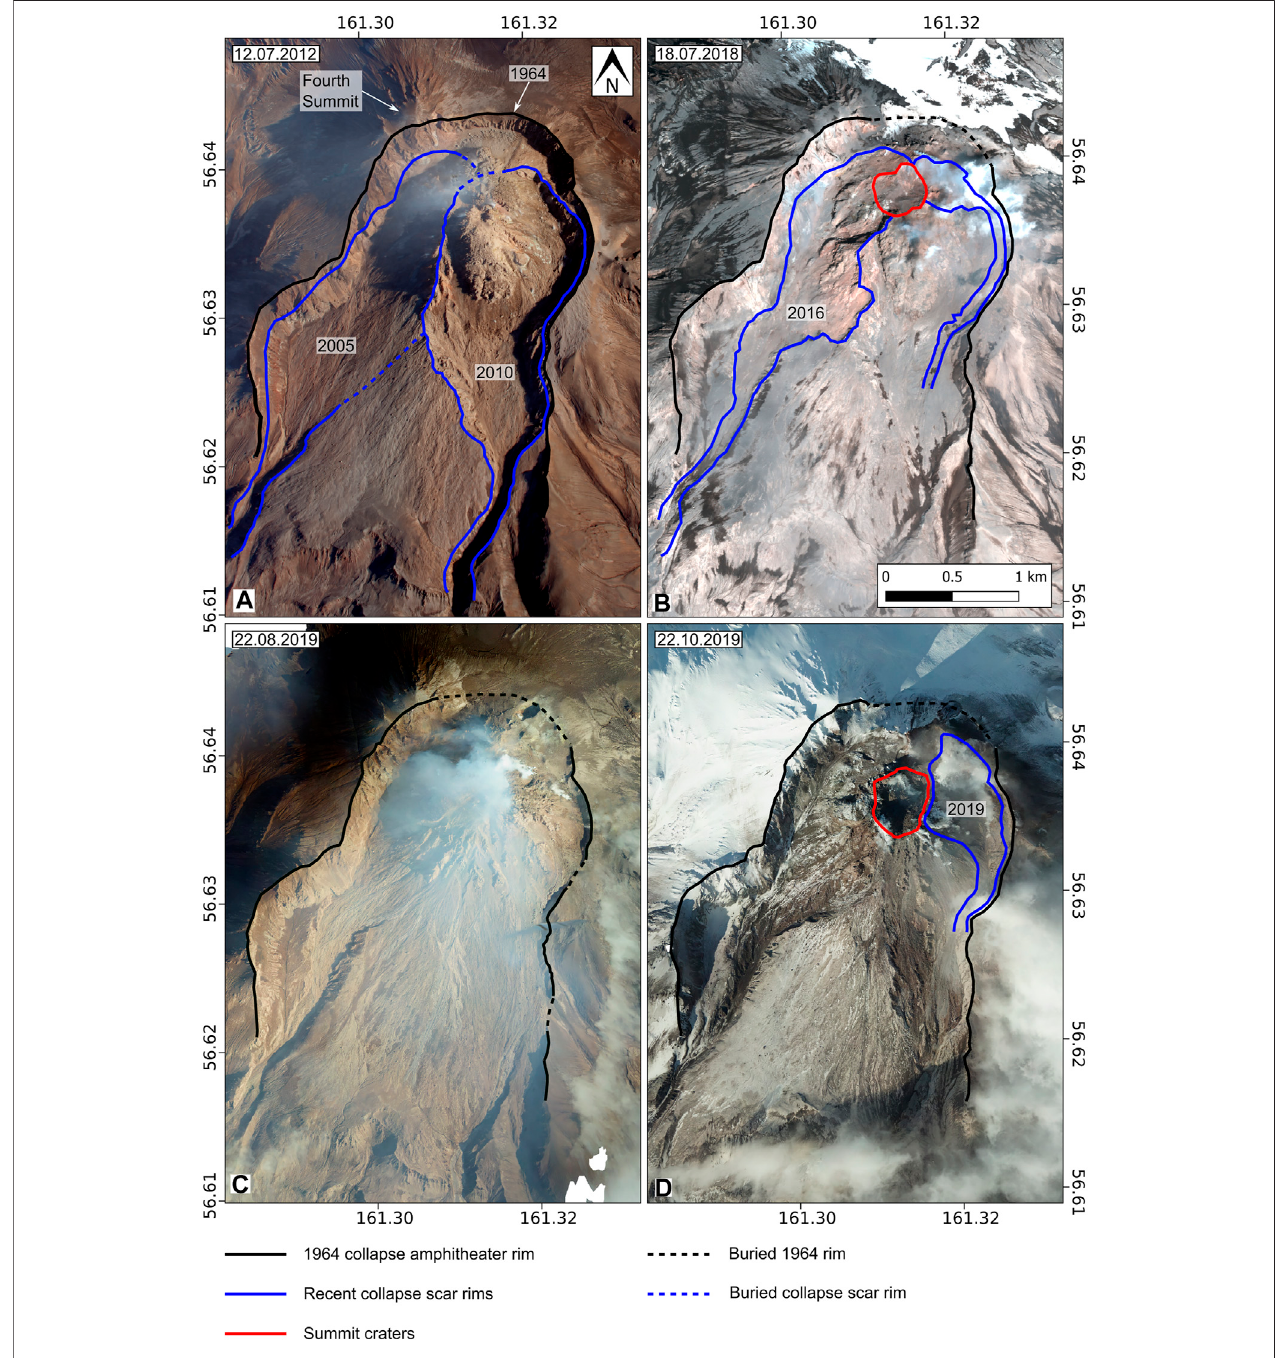
FIGURE 2 | Orthophotos of Young Shiveluch constructed from aerial (A,C,D) and Pleiades satellite (B) data with the main destruction features indicated by the colored lines.